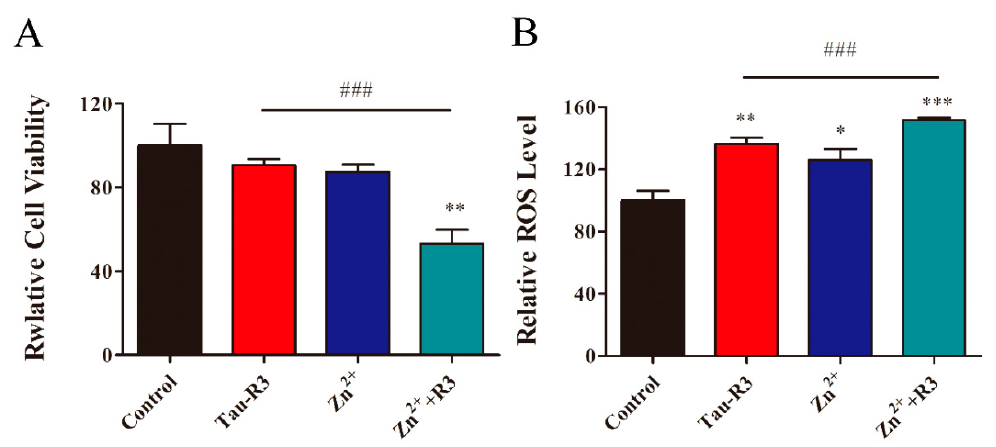
Figure 6. ( A ) Cell viability of Neuro-2A (N2A) cells tested by Cell-Counting Kit-8 Assay upon treatment with: lane 1, the control experiment; lane 2, tau-R3 aggregates; lane 3, Zn 2+ ; and lane 4, Zn 2+ -tau-R3 aggregates. ( B ) The reactive oxygen species (ROS) levels in N2A cells upon treatment with: lane 1, the control experiment; lane 2, tau-R3; lane 3, Zn 2+ ; and lane 4, Zn 2+ plus tau-R3. ROS in living N2A cells were monitored by a fluorescence assay kit consisting of 2 ′ ,7 ′ -dichlorofluorescin diacetate and quantified with flow cytometry. The final concentrations of tau-R3 and Zn 2+ are 15 μ M and 7 μ M. (* p < 0.05, ** p < 0.01, *** p < 0.001 vs. control group; ### p < 0.001 vs. tau-R3 treated group).